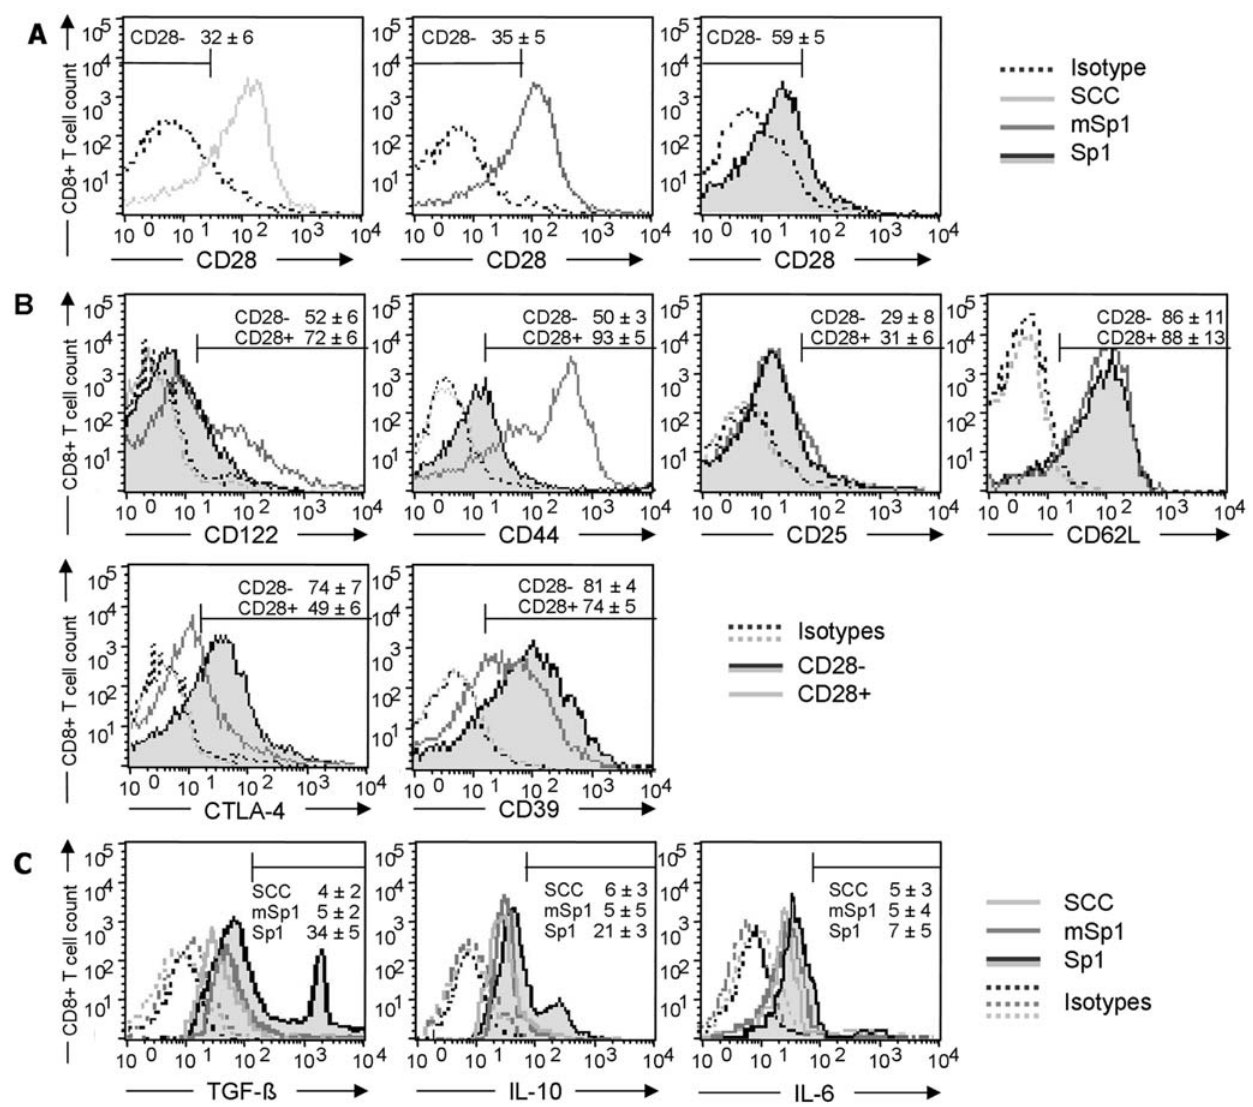
Figure 2. Phenotype of Sp1-induced CD8 + CD28 2 T lymphocytes invivo . C57BL/6 WT mice were challenged intraperitoneally with Sp1, mSp1 (100 m g/mouse, respectively), or SCCA alone. After 18 h, spleen cells were isolated. Cells were stained for CD8 and CD28 surface expression and prepared for flow cytometry. Flow cytometry histograms in A–C are representative for one out of five experiments with 4 mice each. A. Intraperitoneal Sp1 application induces CD8 + CD28 2 T lymphocytes in vivo . The percentages 6 SD (n=4) of the respective CD8 + CD28 2 cells are given above the marker. B. For determination of the phenotype of the Sp1-induced CD8 + CD28 2 T lymphocytes in C57BL/6 mice, CD8 + CD28 2 and CD8 + CD28 + T cells were stained with antibodies specific for surface markers and prepared for flow cytometry analysis. Percentages of positive cells 6 SD (n=4) for the CD8 + CD28 2 and CD8 + CD28 + T cell subsets are displayed above the marker. C. C57BL/6 WT mice were challenged intraperitoneally with Sp1, mSp1 (100 m g/mouse, respectively), or SCC alone. After 18 h, spleen cells were isolated. CD8 + CD28 2 cells were analyzed for LAP surface expression and intracellular cytokines by flow cytometry. Percentages of positive cells 6 SD (n=4) are given below the marker.